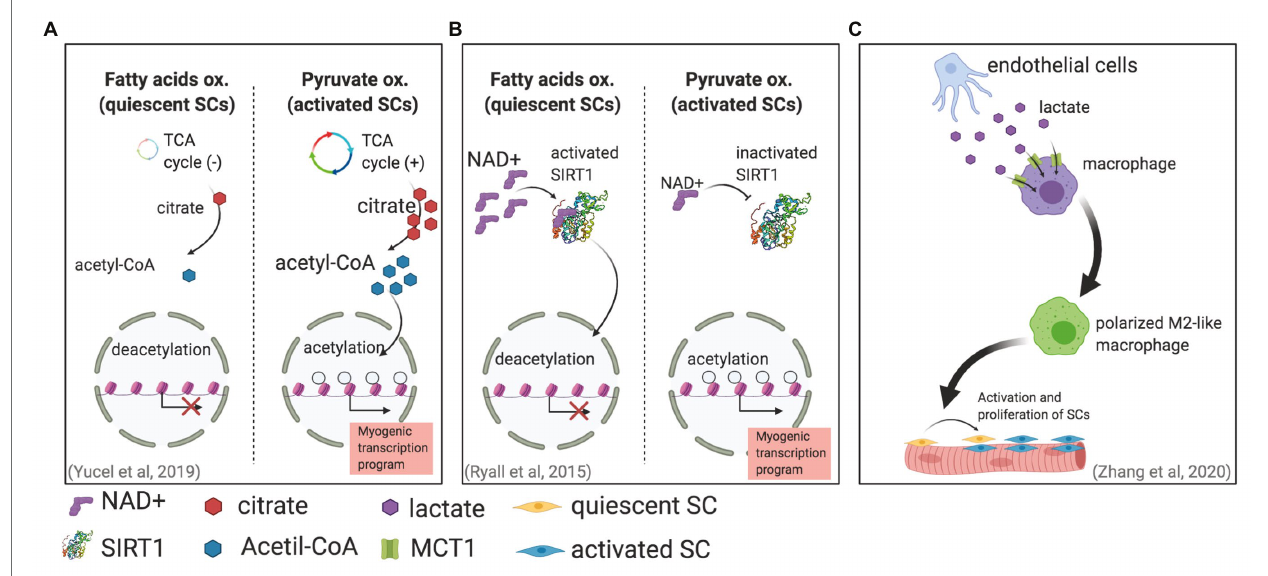
FIGURE 1 | Different mechanisms in which metabolism can affect satellite cell (SC) fate. (A) SC activation is associated with an increase in pyruvate oxidation. This increase generates more citrate production, leading to more acetyl-CoA for histone acetylation that will enable gene transcription (Yucel et al., 2019). (B) Activated SCs increase pyruvate oxidation, reducing NAD+ and therefore SIRT1 activity. The result is higher histone acetylation and an activated myogenic transcriptional program. (C) Endothelial cells can secrete lactate that enters and induces the polarization of macrophages, supporting muscle regeneration by promoting SC proliferation and fusion (Zhang et al.,